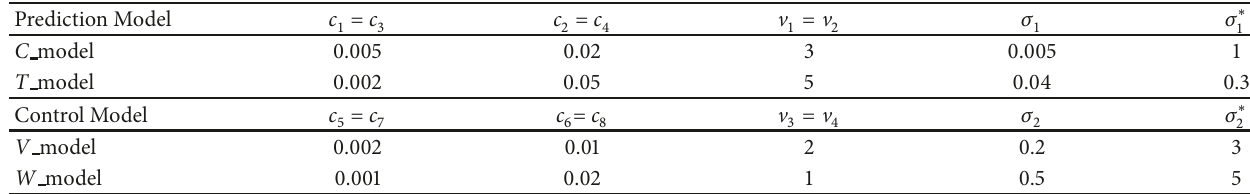
Figure 6: Performance of error distributions with proposed static control model. Table 6: Specified parameters of prediction and control models.